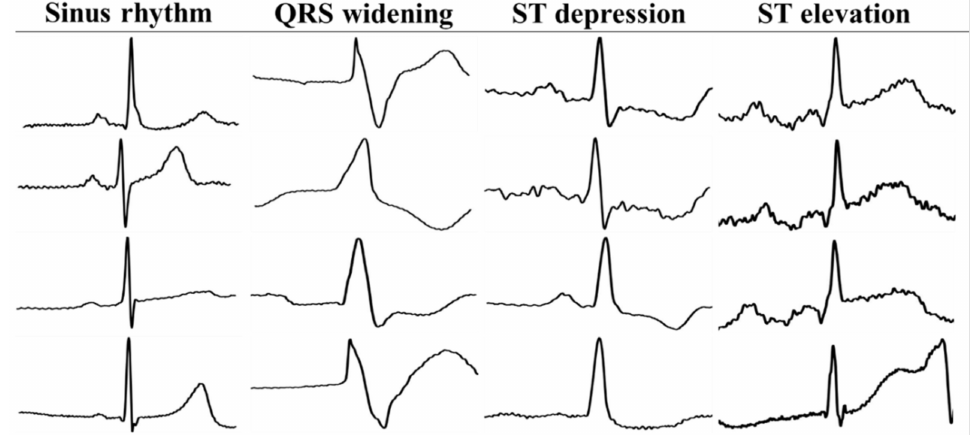
Figure 4. The patterns of QRS widening, sinus rhythm, ST depression, and ST elevation automatically extracted from sequence ECG signals. Table 1. The numbers of 2D images of four patterns of ECG.